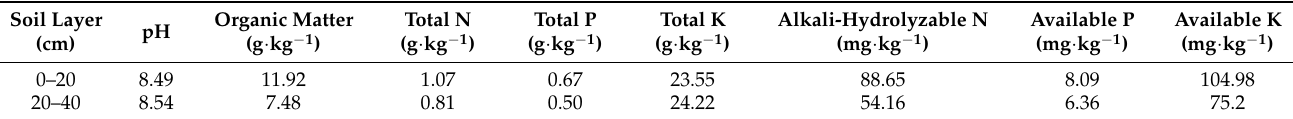
Table 1. The selected chemical properties of the basic